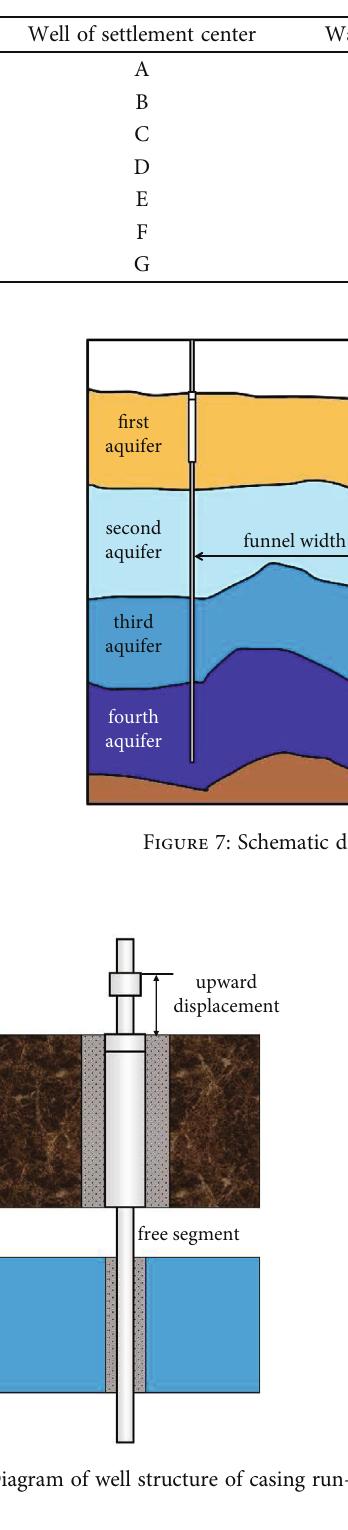
Table 1: Table of surface settlement in Jidong Oil fi eld.